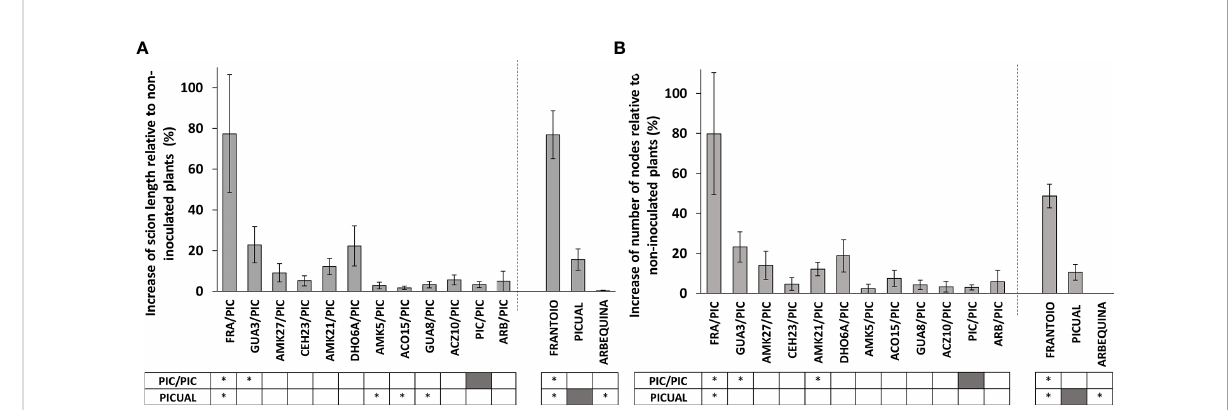
FIGURE 3 Percentage of increase of scion length (A) and number of nodes (B) of Verticillium dahliae -inoculated ‘ Picual ’ x rootstock combinations at 120 days after inoculation (dai), relative to non-inoculated plants. Asterisks indicate signi fi cant differences with the inoculated self-grafted ‘ Picual ’ (PIC/PIC) and non-grafted ‘ Picual ’ plants, respectively. Results are the mean of 12-16 inoculated plants and 3-6 non-inoculated plants. Error bars correspond to the standard error.